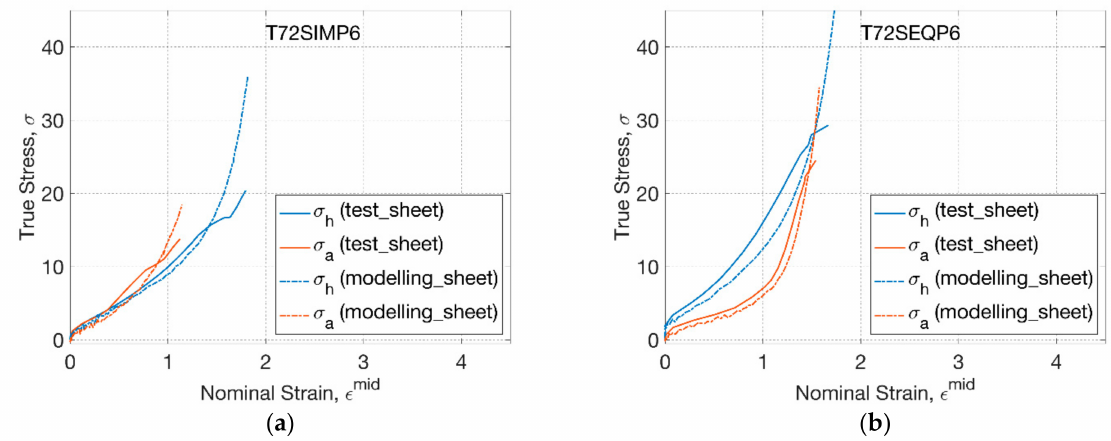
Figure 7. Constitutive modelling of sheet under replicative biaxial test: ( a ) T72SIMP6, ( b )